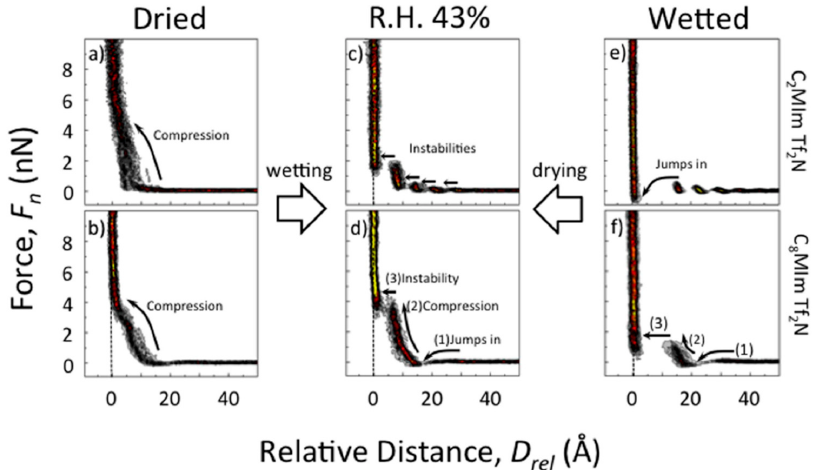
Figure 14. Investigation of the interface between mica and [C 2 MIm][TFSI] (a, c, e) and [C 8 Mim][TFSI] (b, d, f)using force-separation histograms at different water contents. Adapted from Cheng et al. [105].